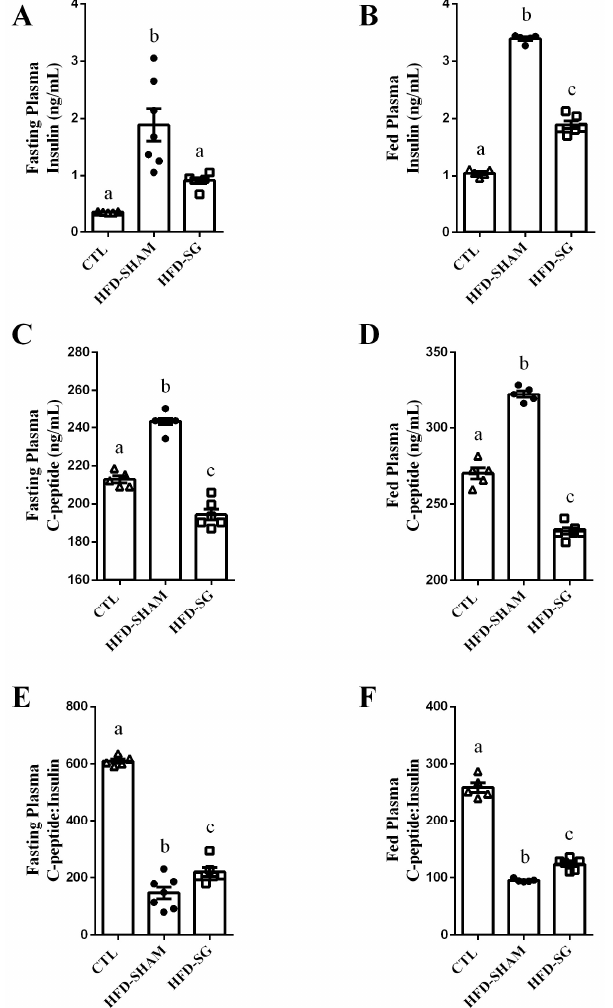
Figure 3. SG decreases fasting and fed insulin and C-peptide levels while increasing hepatic insulin clearance in HFD-SG mice. Plasma insulin in fasting ( A ) and fed ( B ) state of CTL, HFD-SHAM, and HFD-SG mice (n = 5–7). Plasma C-peptide in fasting ( C ) and fed ( D ) state of CTL, HFD-SHAM, and HFD-SG mice (n = 5–7). The C-peptide:insulin ratio in fasting ( E ) and fed ( F ) state of CTL, HFD- SHAM, and HFD-SG mice (n = 5–7). Data are the mean ± SEM. Different letters indicate statistical differences between groups, p ≤ 0.05 (one-way ANOVA or Kruskal–Wallis